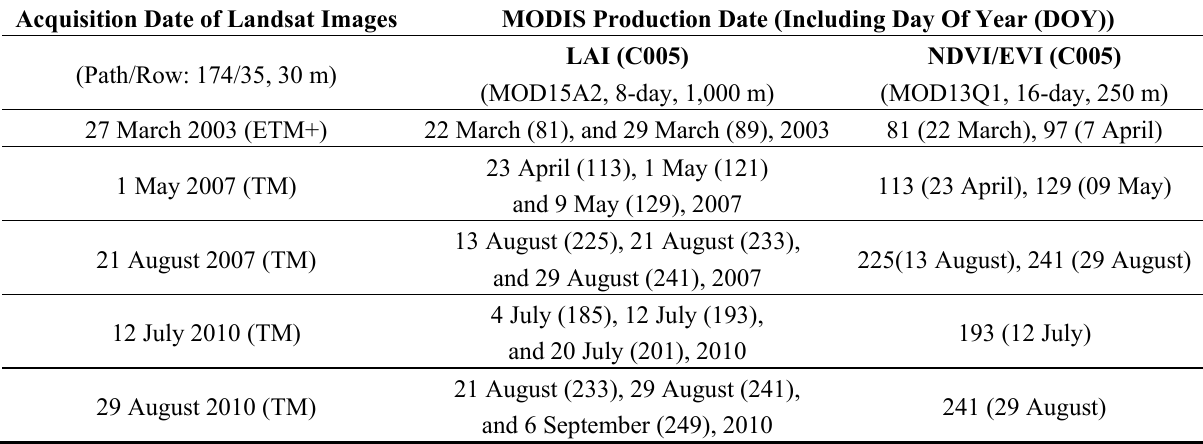
Table 3. Satellite data used in the